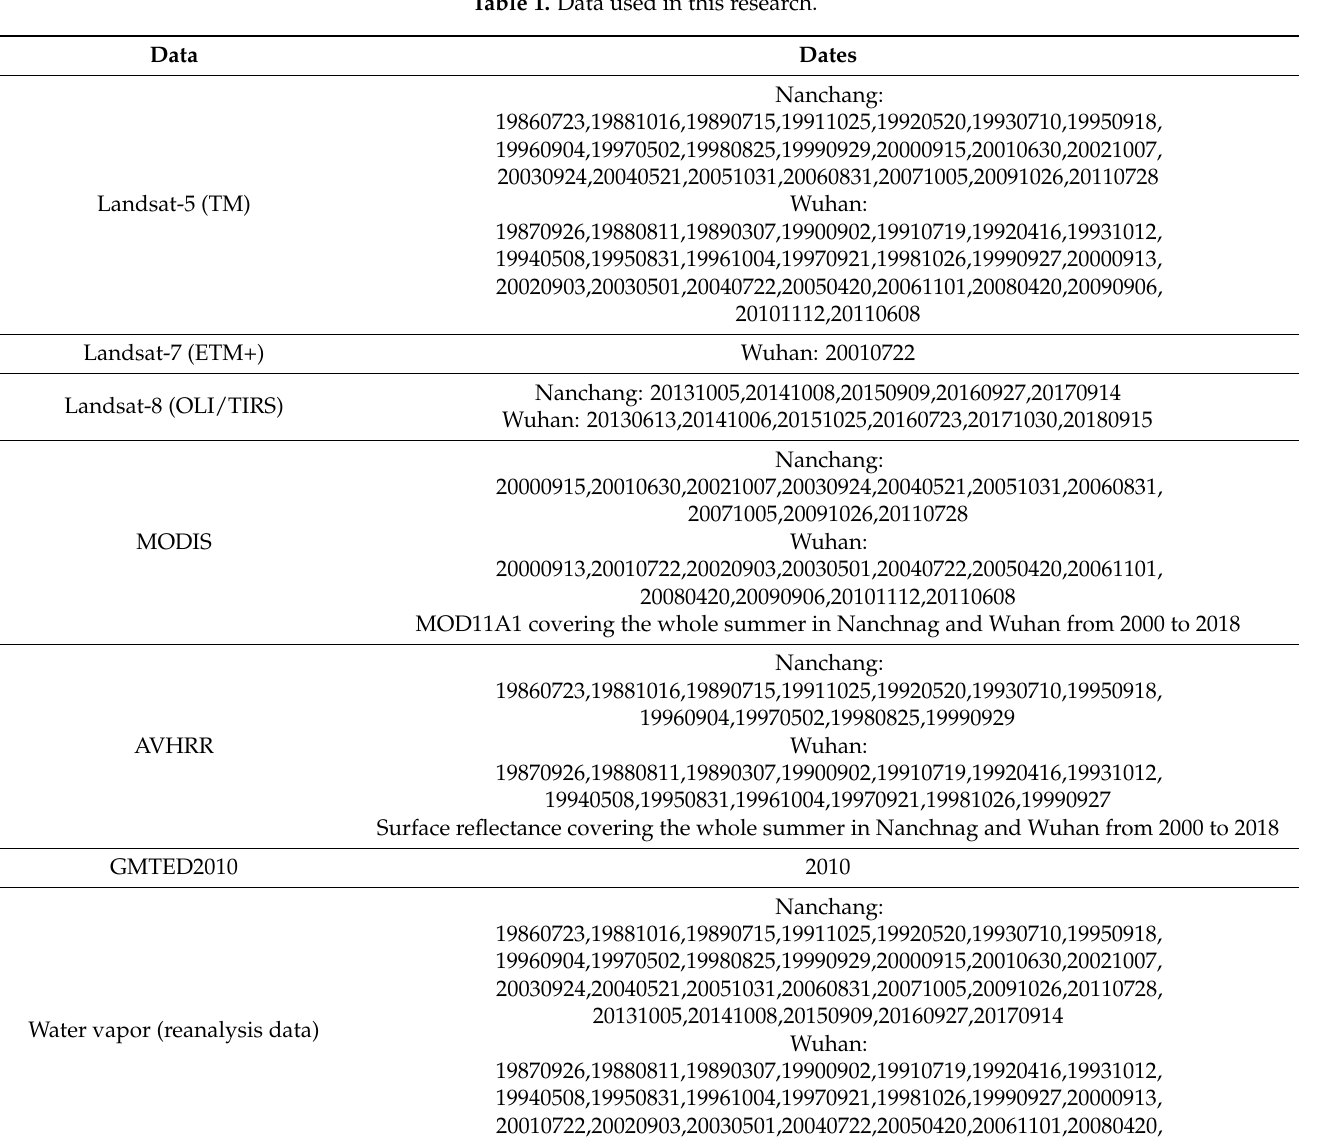
Table 1. Data used in this